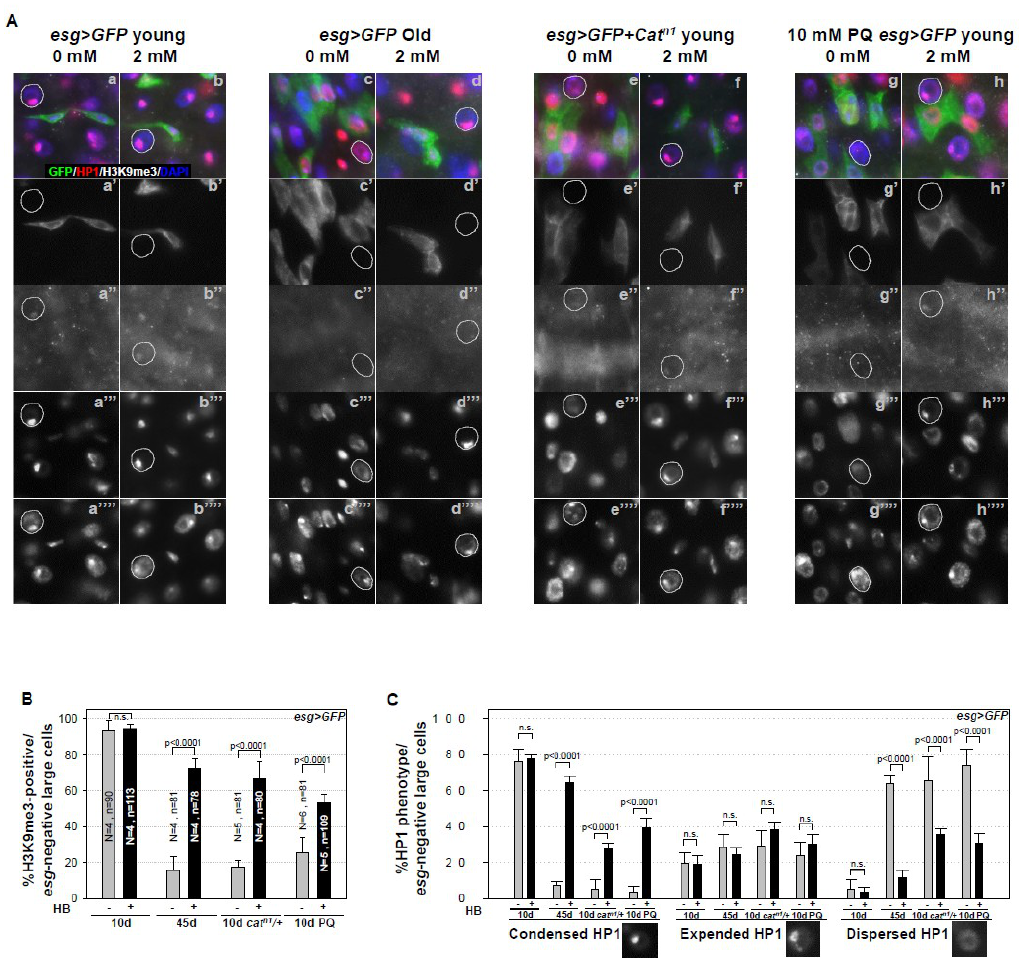
Figure 3. β -HB inhibits age- and oxidative stress-induced heterochromatin instability in midgut ECs. ( A ) Guts from 10-day-old esg > GFP flies (a–b””), 45-day-old esg > GFP flies (c–d””), and 10-day-old esg > GFP + Cat n1 mutant flies (e–f””), without (a–a””, c–c””, e–e””) or with (b–b””, d–d””, f–f””) 2